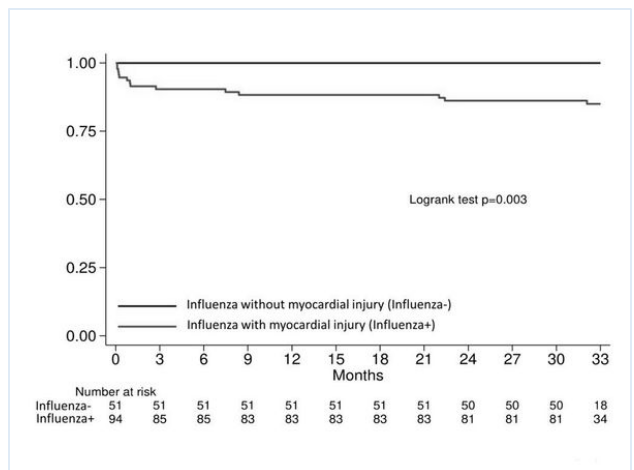
Figure 1. All-cause death at follow-up .